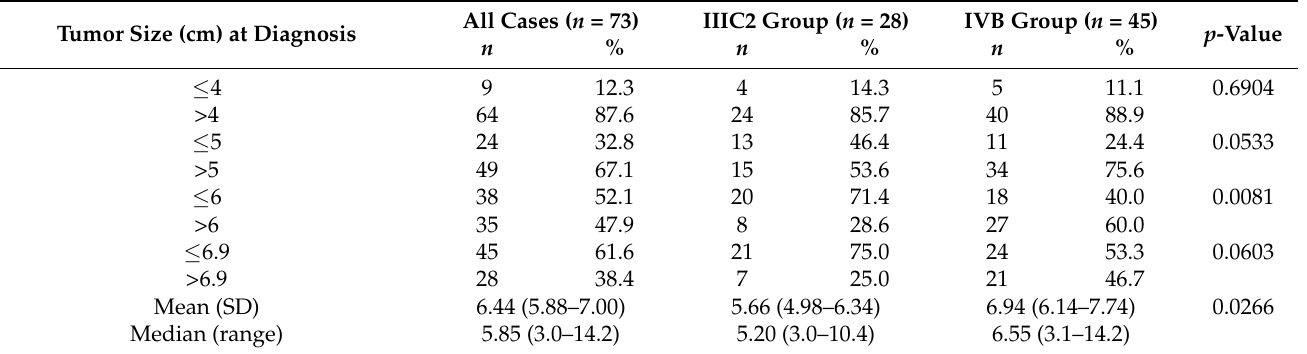
Table 2. Tumor size distributions.